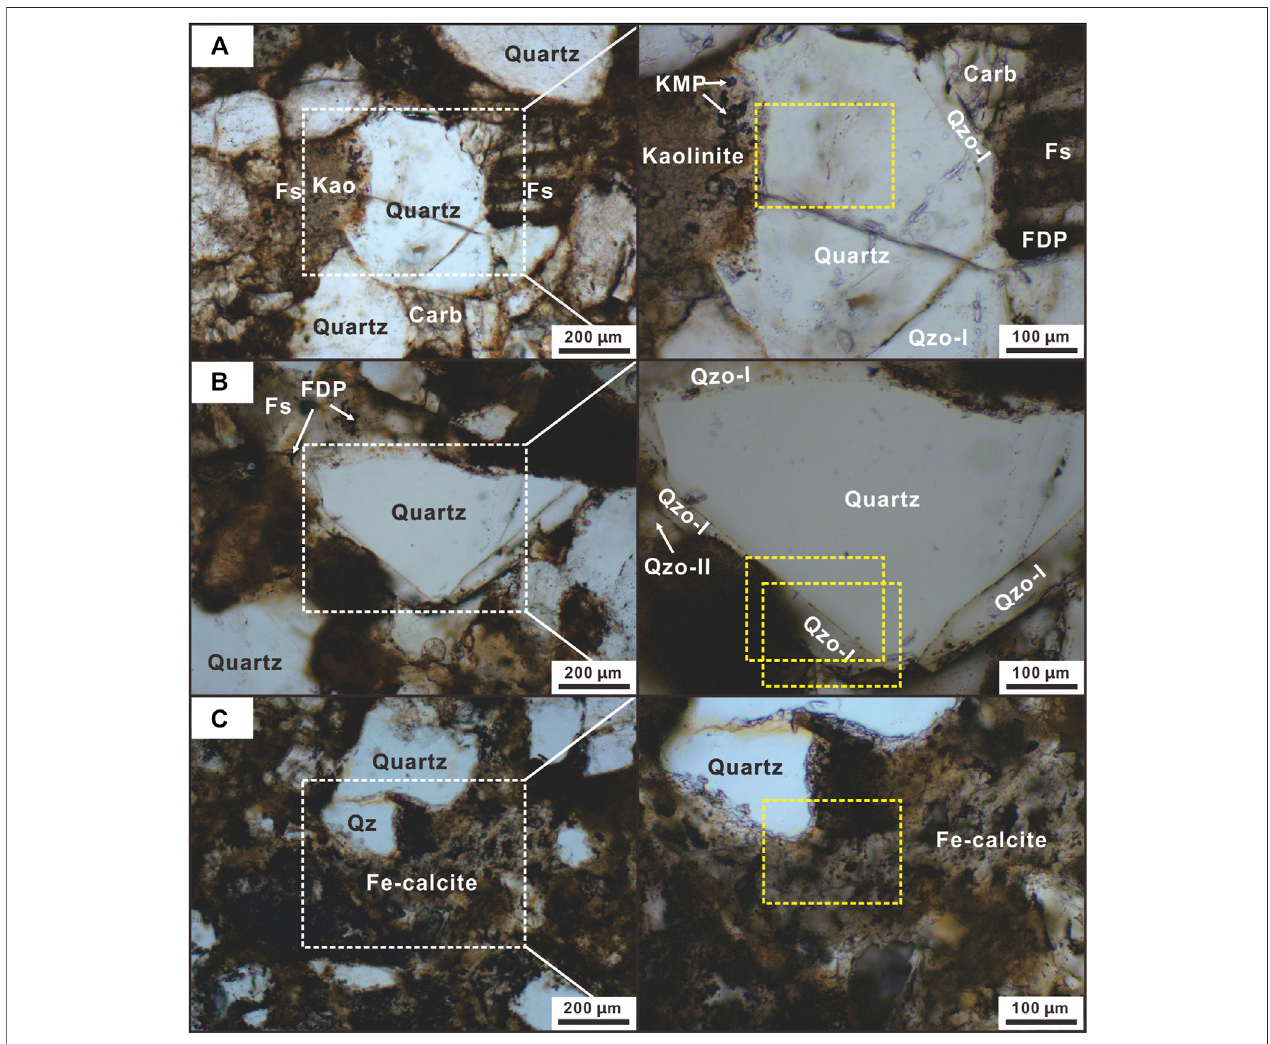
FIGURE3| PetrographicfeaturesofdiageneticphenomenaandsequenceinthesandstonesintheDongyingDepression. (A) Feldspardissolutionwascoevalwith the quartz and kaolinite precipitation. (B) two generations of quartz overgrowth. (C) Fe-calcite replaced the primary quartz particle and fi rst overgrowth generation. Qz, quartz; Fs, feldspar; Kao, kaolinite; Carb, carbonate; Qzo, quartz overgrowth; FDP, feldspar dissolution pore; KMP, intercrystalline micropores of kaolinite.